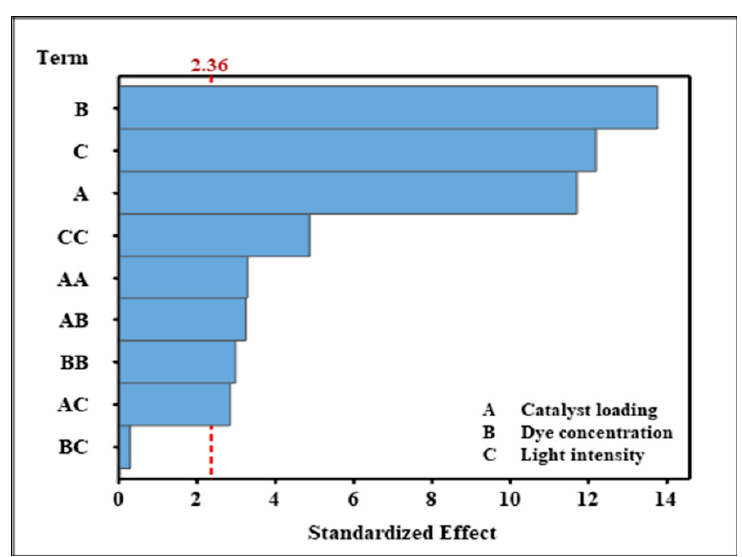
Figure 2. Pareto chart of the standardized effects of the model parameters.